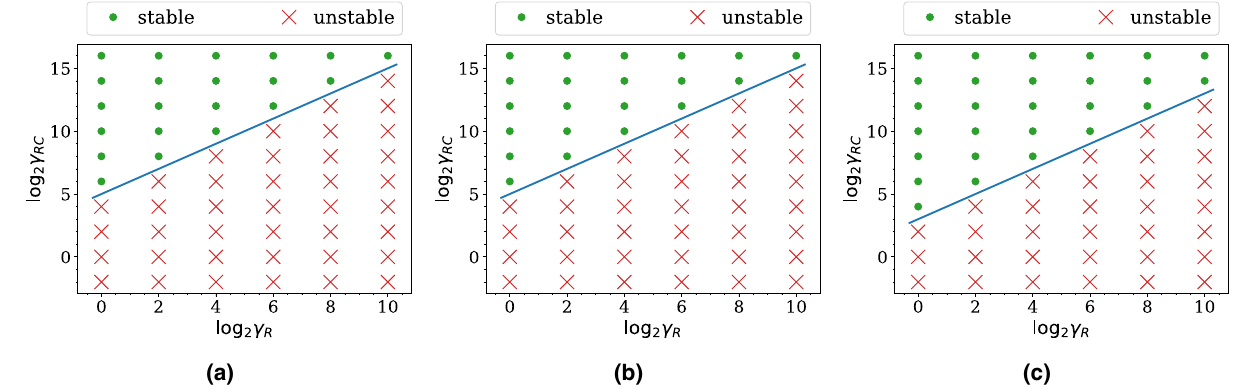
Figure 7. Stability map of the simulations on (a) the coarse grid, (b) the medium grid, and (c) the fine grid of the profunda femoris domain. Notably, the stability and the instability region are separated by a straight line of slope 1 in the maps. The y -intercept of the line is the smallest for the fine 1024 and γ RC 65, 536 , the Q ratios are nearly stationary after six periods of the inlet flow. We also For γ R = = observe a lower convergence rate in the amplitudes than the means of the Q ratios (see Supplementary Fig. S4). Error of flow rate ratios. We evaluate the accuracy of the simulated Q ratios by using the temporal average of these ratios over the last five periods of the inlet flow. Figure 8 shows the comparison between the simulated